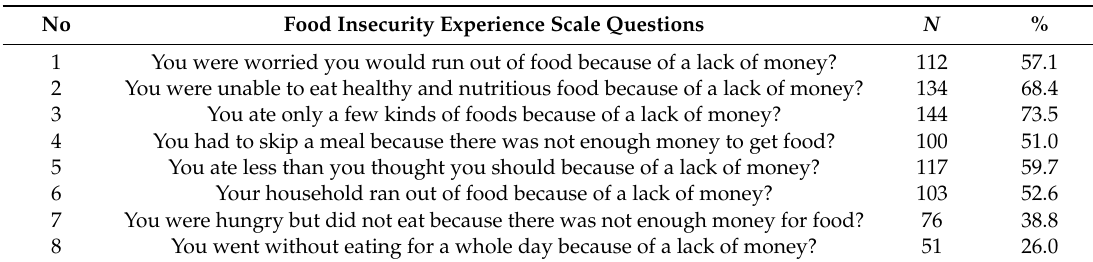
Table 3. Questions of the Food Insecurity Experience Scale and a ffi rmatively answered questions by the study population in Zanzibar ( N = 196). During the last 12 months, was there a time when